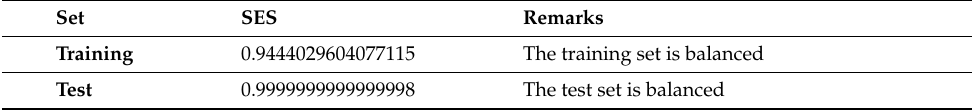
Table 4. SES results for the feline reticulocyte dataset.